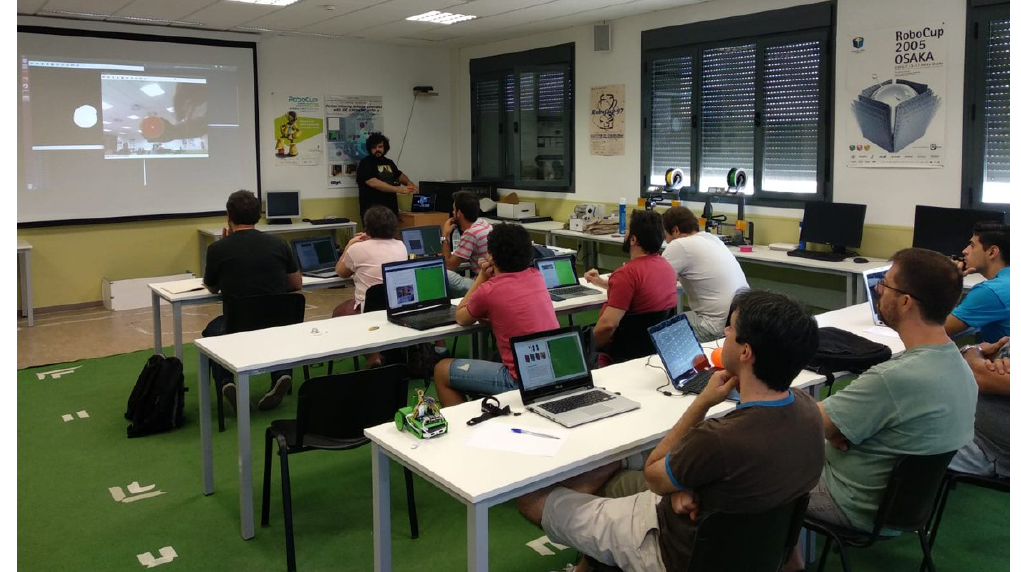
Figure 17. Workshop at Rey Juan Carlos University to train teachers for teaching with JdeRobot-Kids framework using PiBot